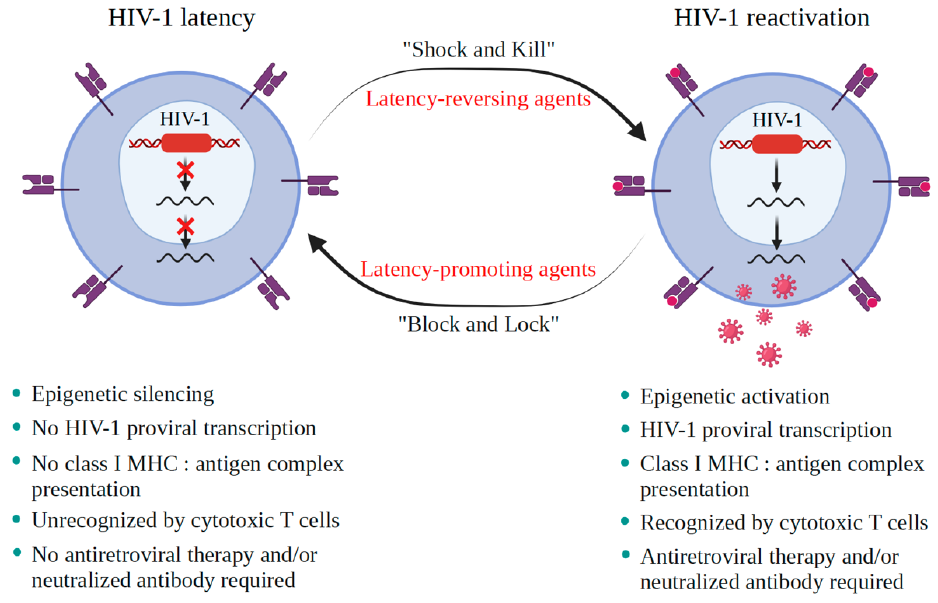
Figure 1. Concepts of “Shock and Kill” and “Block and Lock” strategies in AIDS therapy. Latency- reversing agents induce HIV-1 transcription via epigenetic activations in the “Shock” step.